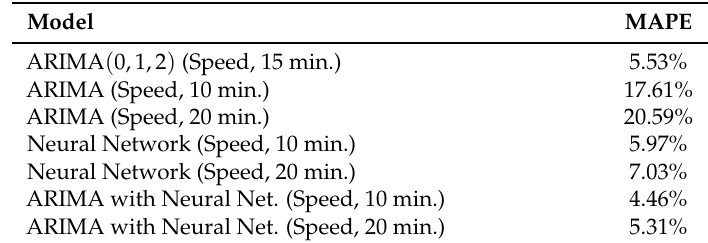
Table 1. Performance of the ARIMA(0,1,2) model, using the metric defined in Equation (10), in comparison with different data sets and models reported in